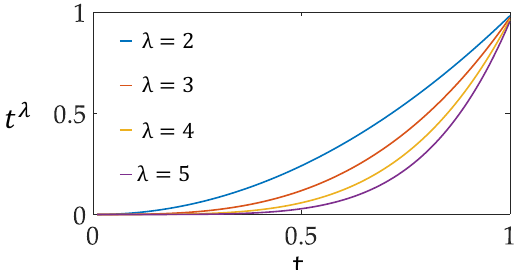
Figure 2. Shape of the nonlinear suppression function with different choices of λ in the background suppression process.